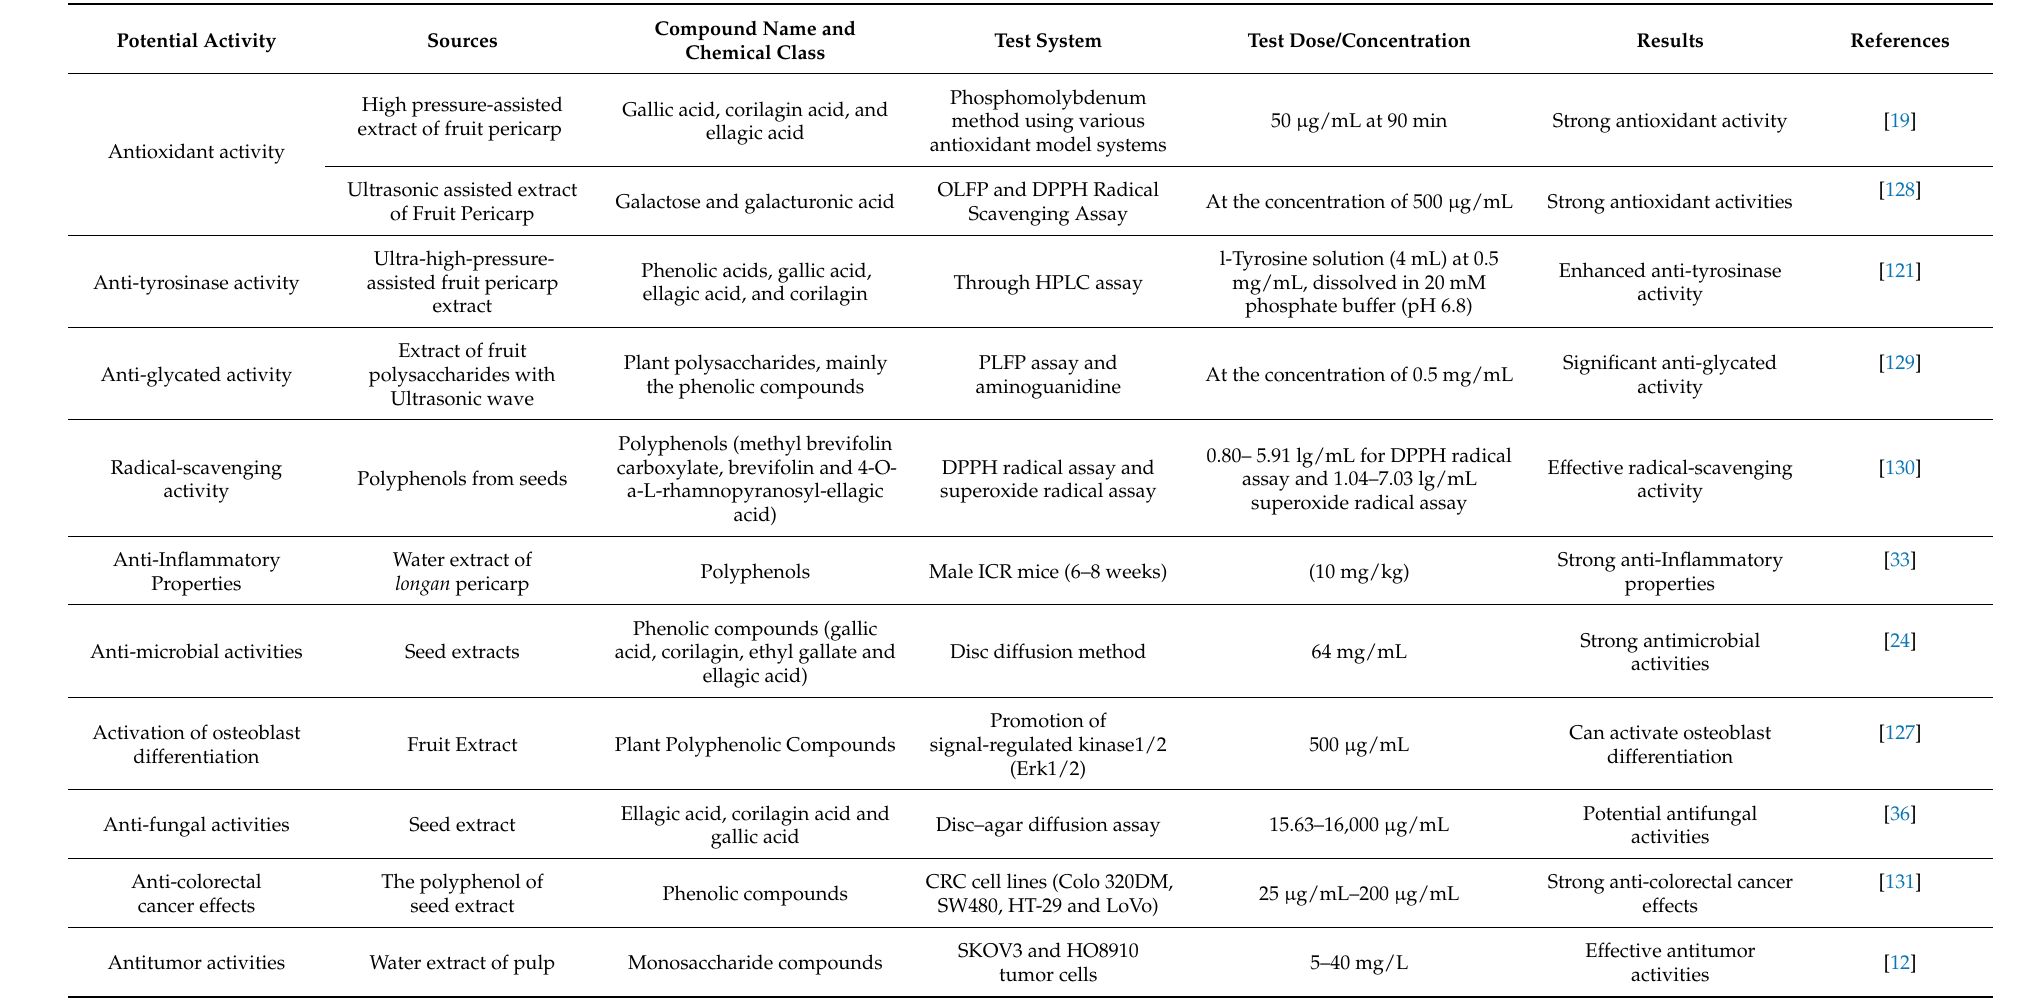
Table 4. Potential pharmacological activities of “ Dimocarpus longan ”